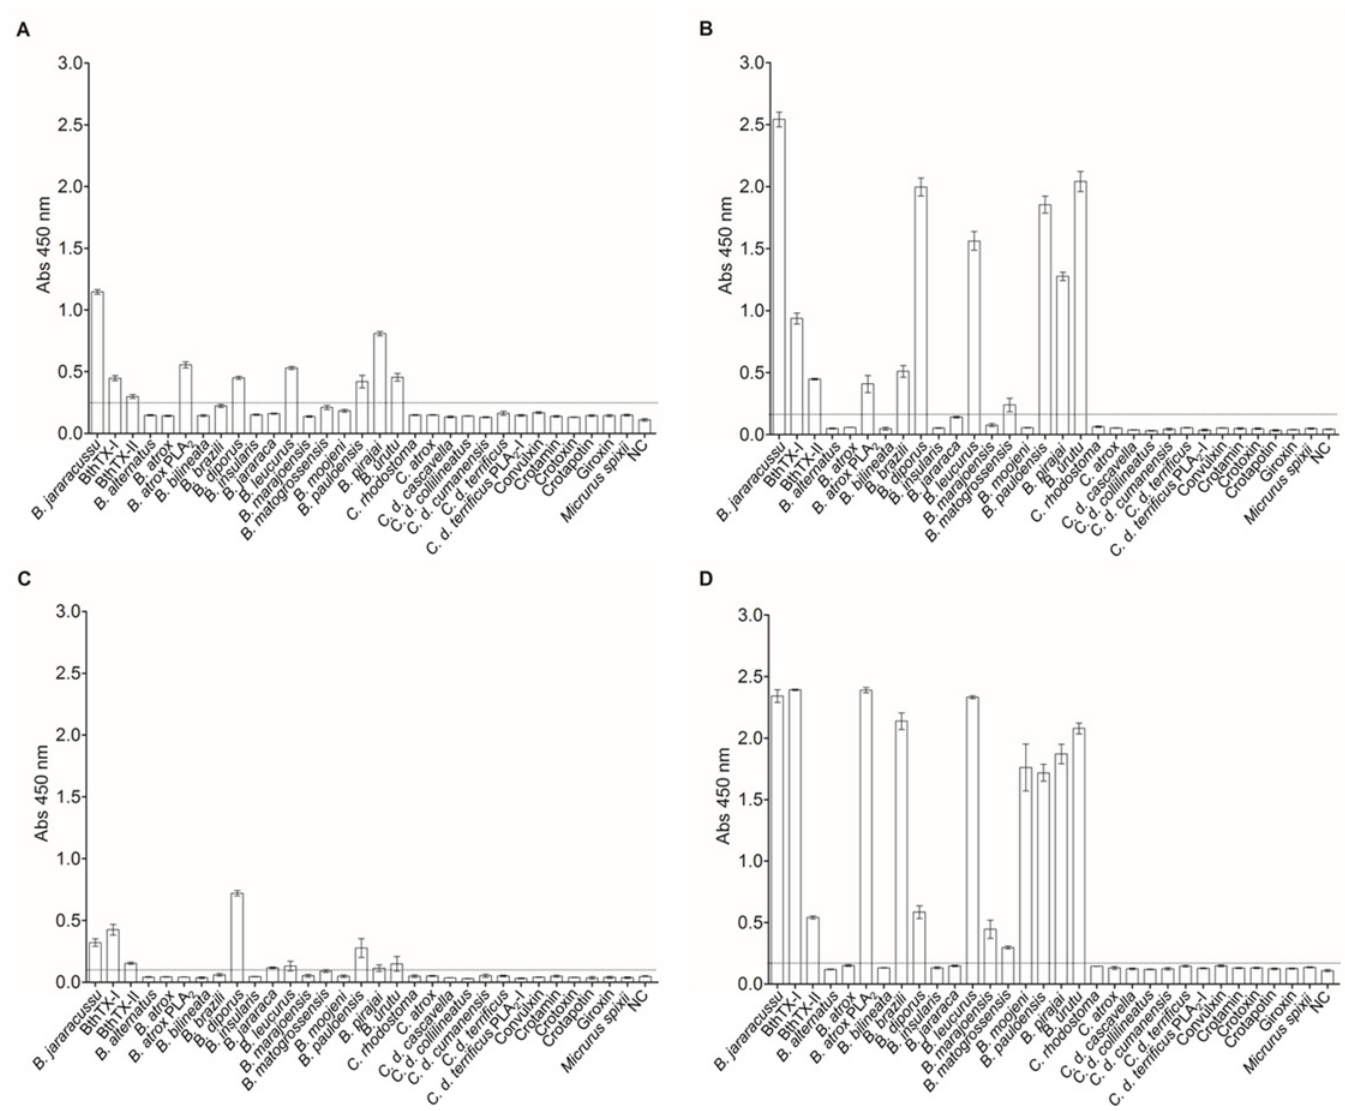
Fig 6. Cross-reactivity of anti-BthTX-I and BthTX-II VHHs. In vitro reactivity showing different levels of interaction of selected VHHs (A) KF498607; (B) KF498608; (C) KF329715; (D) KC329718 with a variety of snake venoms ( Bothrops alternatus , Bothrops atrox , Bothrops bilineata , Bothrops brazili , Bothrops diporus , Bothrops insularis , Bothrops jararaca , Bothrops leucurus , Bothrops marajoensis , Bothrops matogrossensis , Bothrops moojeni , Bothrops pauloensis , Bothrops pirajai , Bothrops urutu , Calloselasma rhodostoma , Crotalus atrox , Crotalus durissus cascavella , Crotalus durissus collilineatus , Crotalus durissus cumanensis , Crotalus durissus terrificus , Micrurus spixii ), and isolated toxins (PLA 2 from Bothrops atrox , and PLA 2 -I, convulxin, crotamin crotapotin, crotoxin, and giroxin from Crotalus durissus terrificus ). After being coated on the wells, venoms and toxins were probed with selected VHHs. Samples were incubated with mouse anti-His antibody and the reactive signals were detected after incubation with HRP-conjugated anti-mouse IgG produced in goat and TMB. All clones that showed an absorbance value (OD 450nm) higher than the stipulated cut-off point (2 mean OD from negative samples plus 2 standard deviations) were considered positive. The dashed lines represent the cut off. All measurements were performed in triplicate. For the negative control (NC), wells were not coated with venoms or toxins. Error bars represent standard